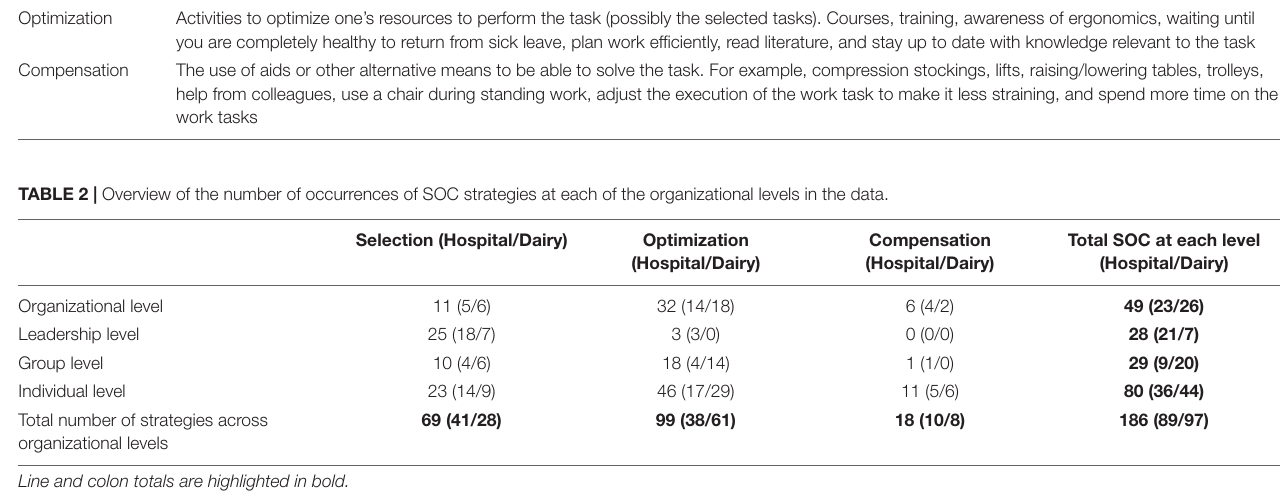
TABLE 1 | Operationalization of selection, optimization, and compensation – definition used to code the empirical data material. Type of strategy Operationalization of the strategies Selection Optimization